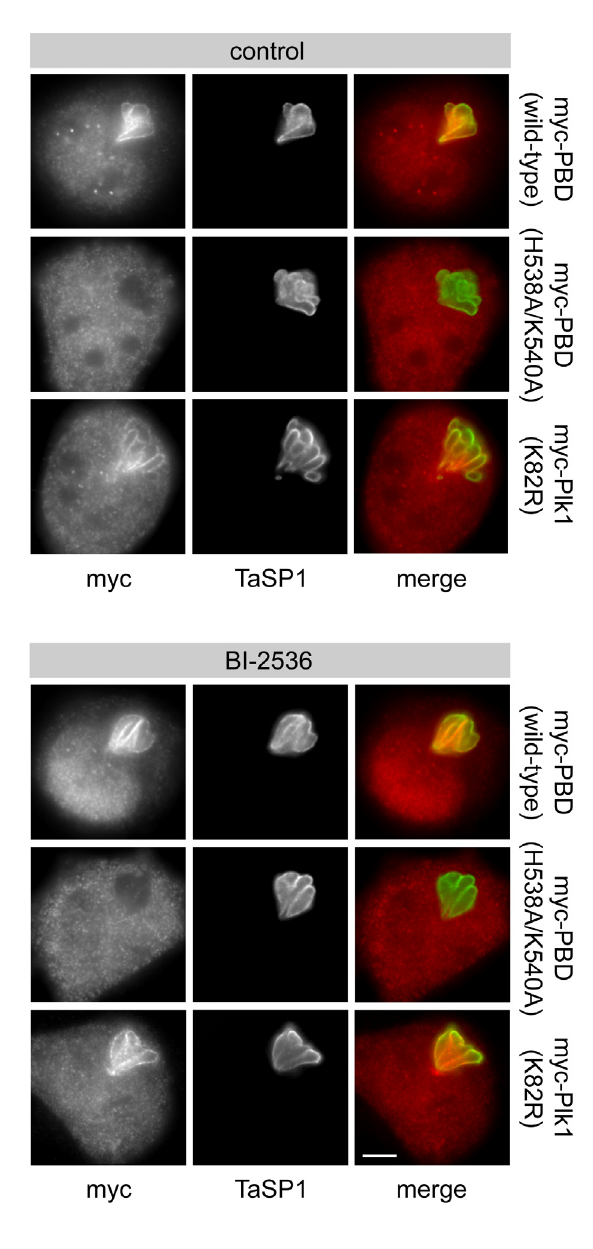
Figure 6. The binding of ectopically expressed Plk1 to the parasite surface does not require Plk1 catalytic activity. T. annulata -infected cells were transfected with plasmids encoding myc- tagged versions of Polo-box domain (myc-PBD, wild type), H538A/ K540A mutant PBD (myc-PBD H538A/K540A), or catalytically inactive Plk1 (myc-Plk1 K82R) and cultured in the presence or absence of BI- 2536 as indicated. Cells were analyzed by IFM using anti-myc and anti- TaSP1 antibodies. Scale bar represents 5 m